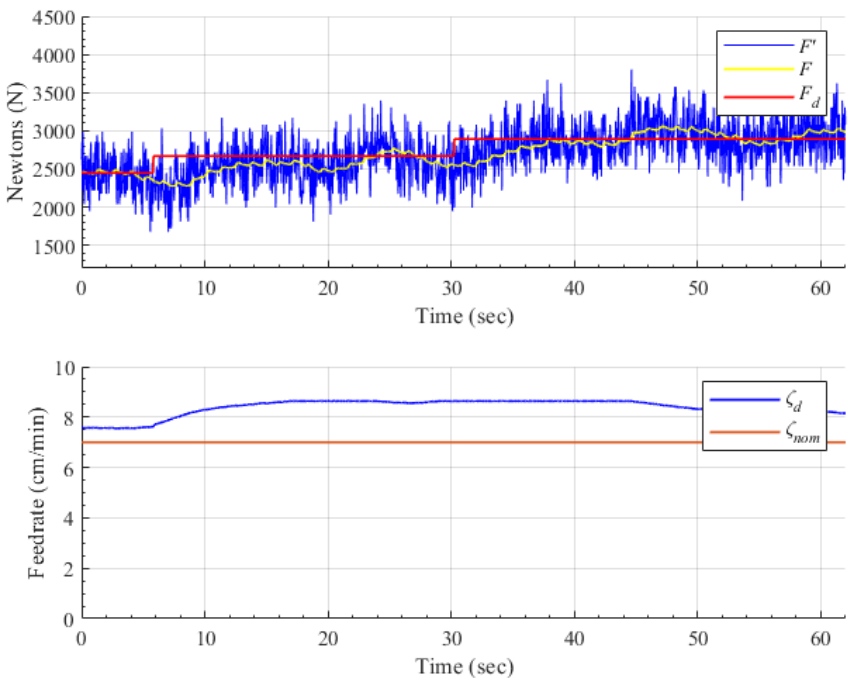
Figure 8. Protocol A. ( Top ) The desired versus measured force. Note, F denotes the filtered version of F (cid:48) , where F was used in feedback. The desired force was manually increased at t ≈ 4 s and t ≈ 29 s. A maximum error of 396.8 N in the filtered force data occurs at t ≈ 45 s. ( Bottom ) The desired and nominal feedrates. The desired feedrate is calculated using (8)–(12) and serves as the reference for the inner loop linear actuator controller.